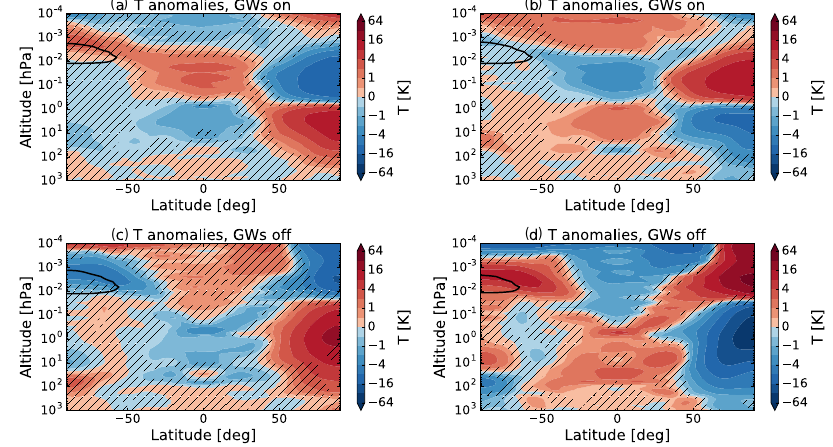
Figure 6. The temperature anomalies for high (a, c) and low (b, d) PW activity, as measured by the temperature in the winter stratosphere (1– 10hPa, 50–60 ◦ N) in January for the control run (a, b) and run without GWs in the winter hemisphere (c, d) . There are 10 years of data with high temperature anomalies and 8 years with low temperature anomalies in the winter stratosphere for the control run. For the run without the GWs in the winter hemisphere, there are 7 years with high temperature anomalies and 5 years with low temperature anomalies. The hatched areas are regions where the data does not reach a confidence level of 95%. The black 150K contour indicates the polar mesopause